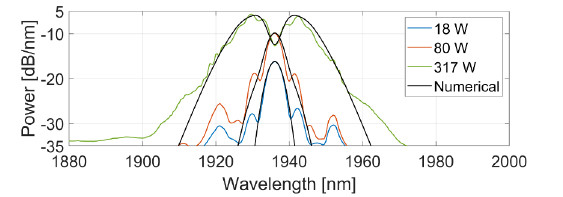
Figure 5. Cross-port optical spectra of OFC #1 for input pulses with di ff erent peak powers.